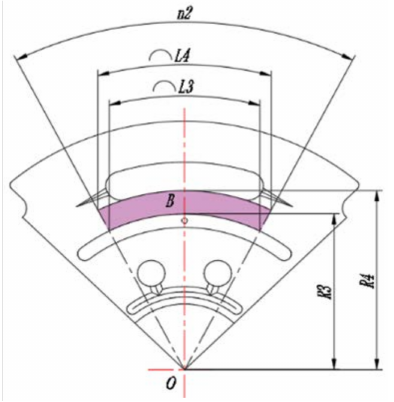
Figure 6. Mathematical calculation model for region